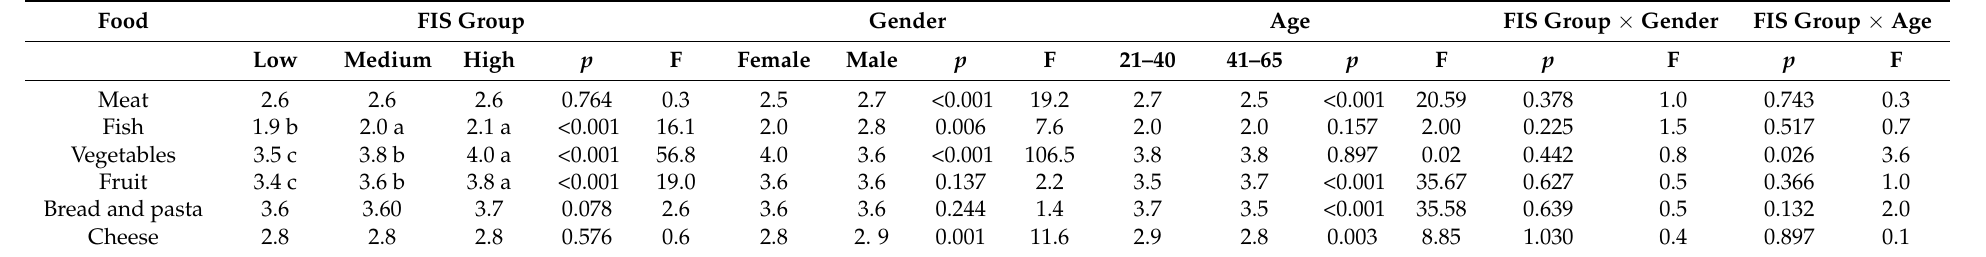
Table 4. Three-way ANOVA model on the importance given to food to help recover in some circumstances. FIS group, gender, and age were used as fixed